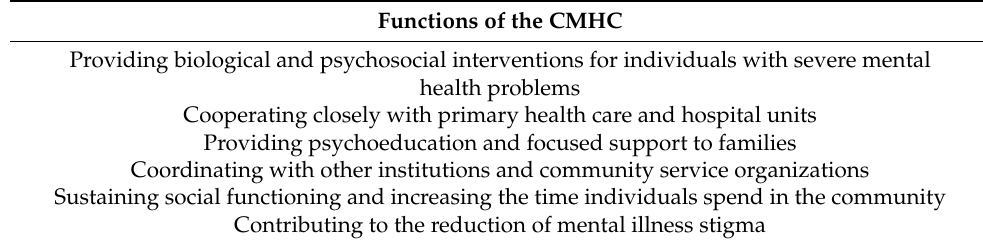
Table 1. Functions of community mental health centers